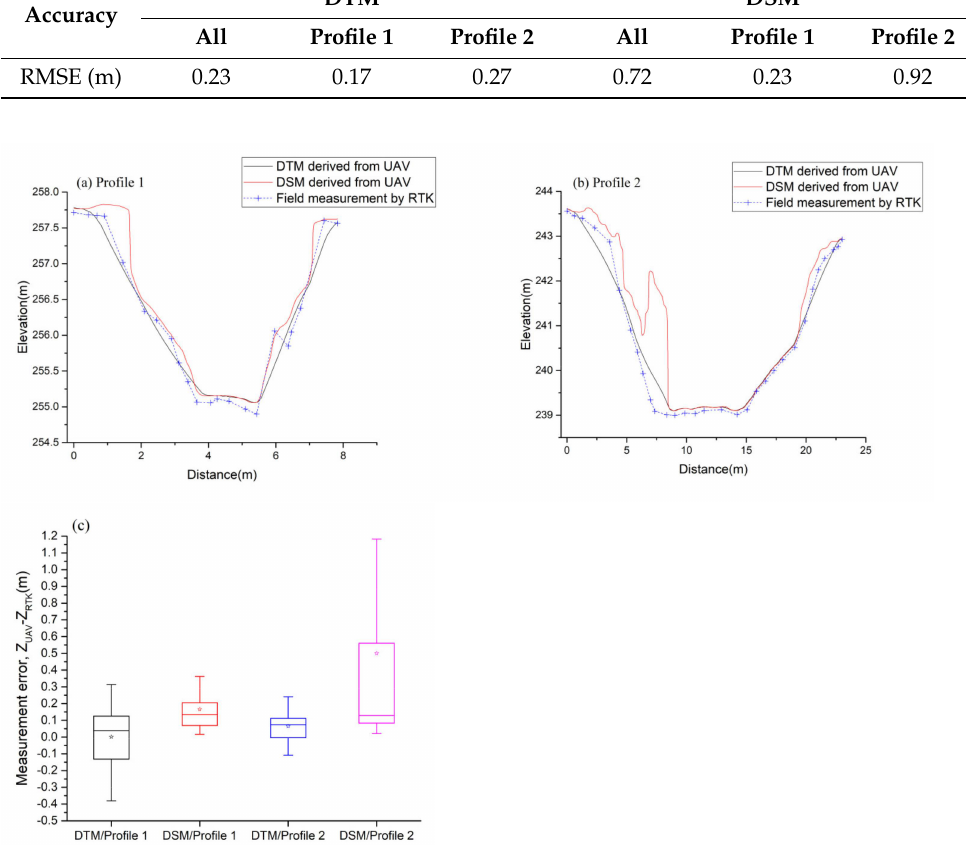
Figure 5. ( a , b ) Vertical difference between UAV-DTM/DSM-derived surface (solid line) and geodetic measured surface (dash line) for Profiles 1 and 2; ( c ) box plot of the height error (elevation difference between UAV and field measurements) for Profiles 1 and